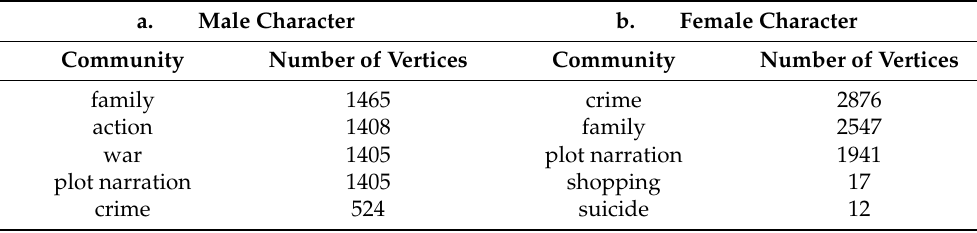
Table 1. Communities identified in the network and their total number of